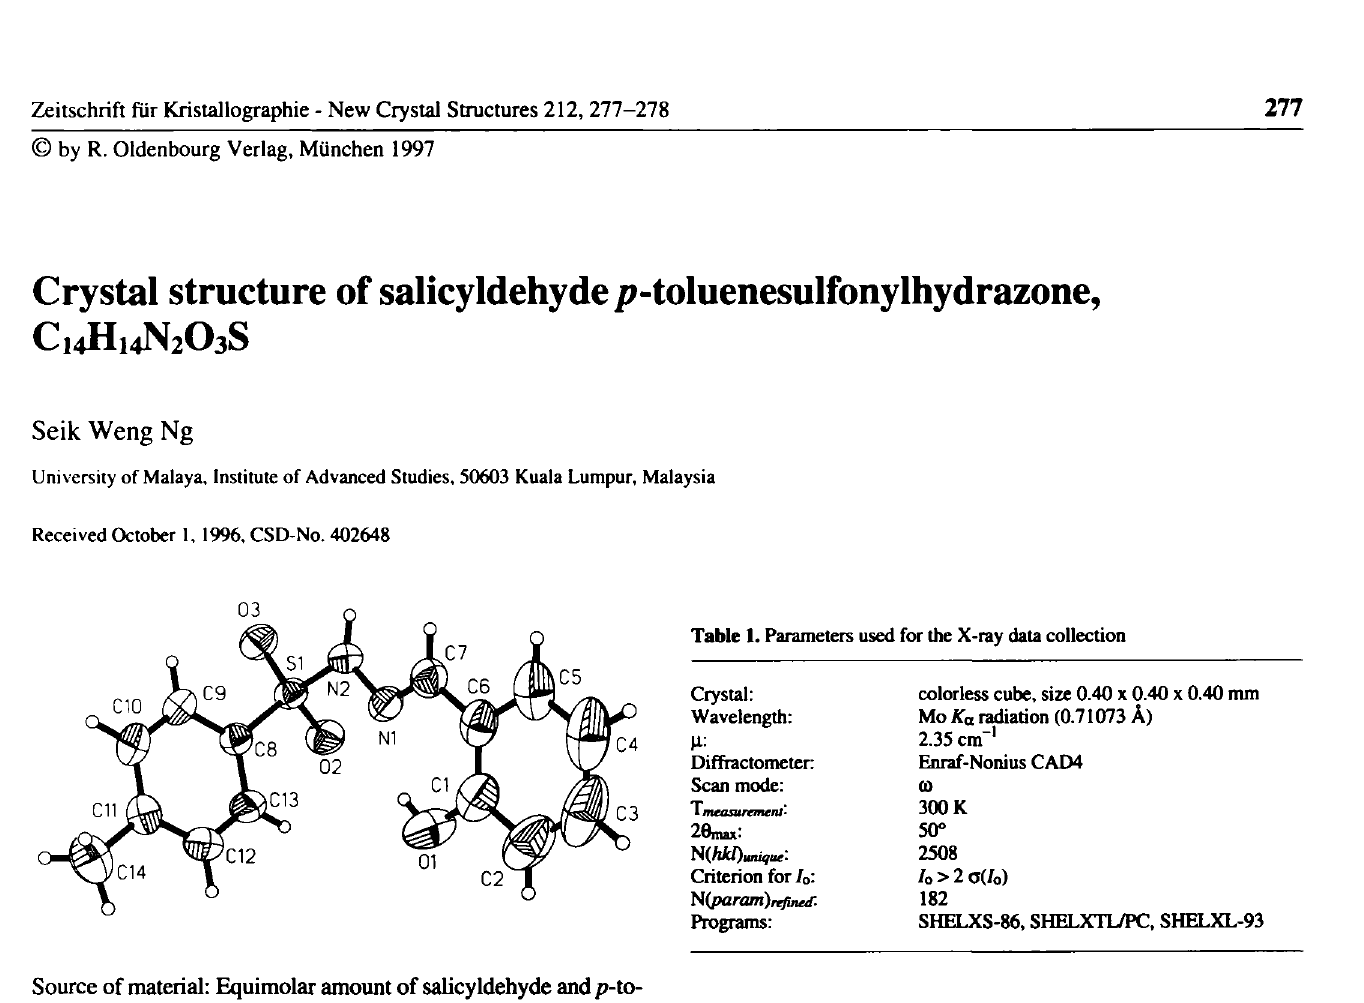
Table 2. Final atomic coordinates and displacement parameters (in Â 2 )